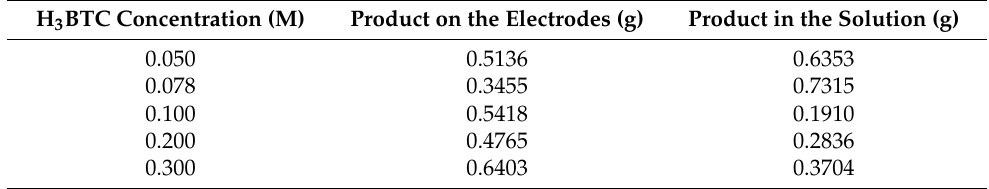
Table 2. The weight of the products on the electrodes and in the solution after 150 min electrosynthesis time with varying H 3 BTC concentrations using 0.250 Hz polarity reversal and 0.8 A current.